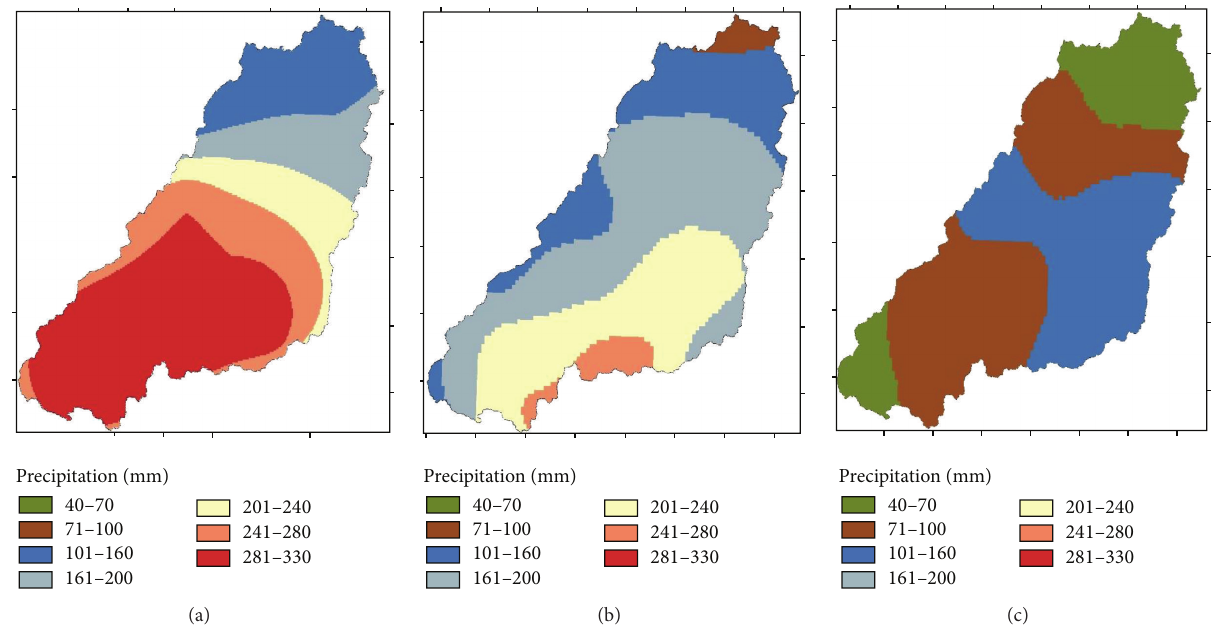
Figure 2: Kriging interpolation of (a) gauge, (b) 3B42V7, and (c) 3B42RT accumulated precipitation estimates,